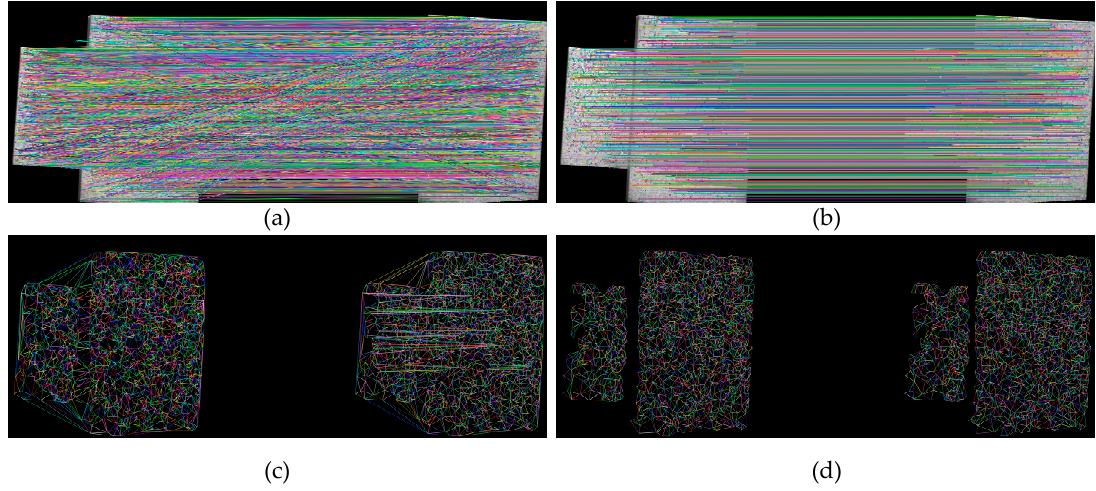
Figure 3. Feature matching by SIFT: ( a ) coarse matches; ( b ) removal of wrong matches by the epipolar line constraint; ( c ) triangulation of matched points in ( b ); and ( d ) removal of wrong matches in ( c ) by setting the area